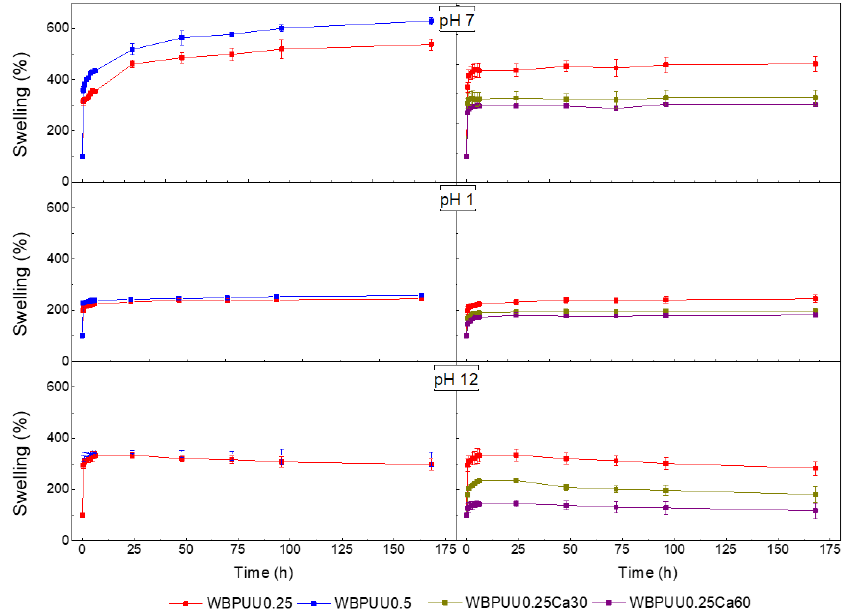
Figure 10. Water absorption capacity of the prepared WBPUU/CNC- and WBPUU/CNC/CaCl 2 - based scaffolds.